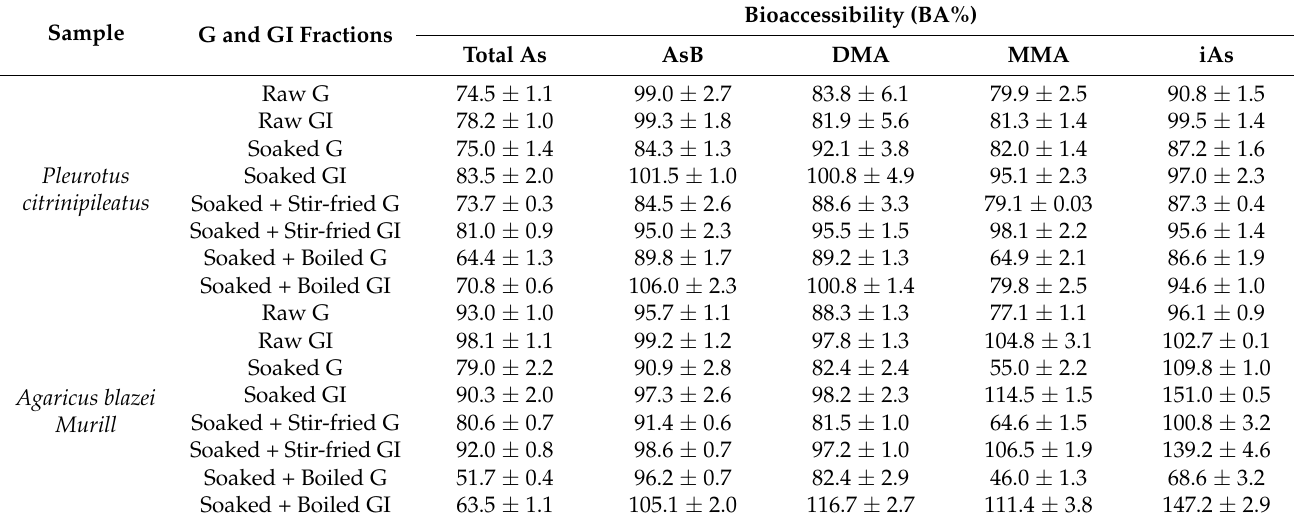
Table 3. Bioaccessibility (BA%) of the total As and its speciation in G and GI fractions of treat- ment